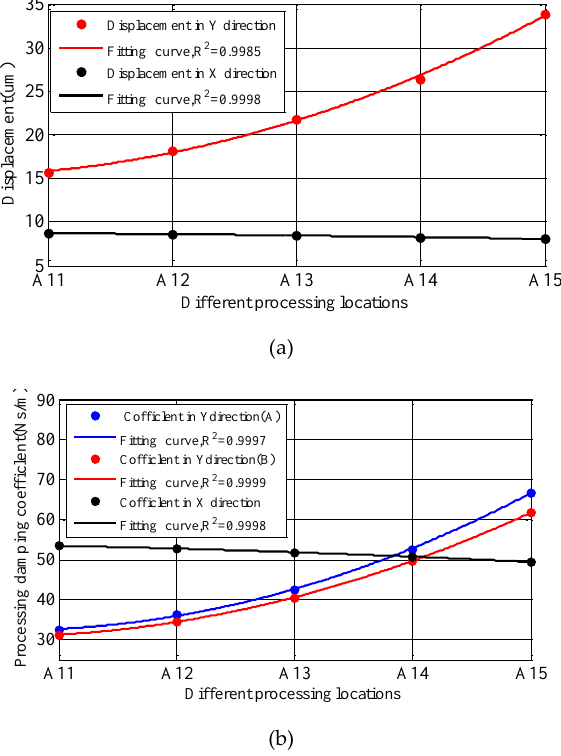
Cofficlent in Ydirection(A) Fitting curve,R 2 =0.9997 Cofficlent in Ydirection(B) Fitting curve,R 2 =0.9999 Cofficlent in X direction Fitting curve,R 2 =0.9998